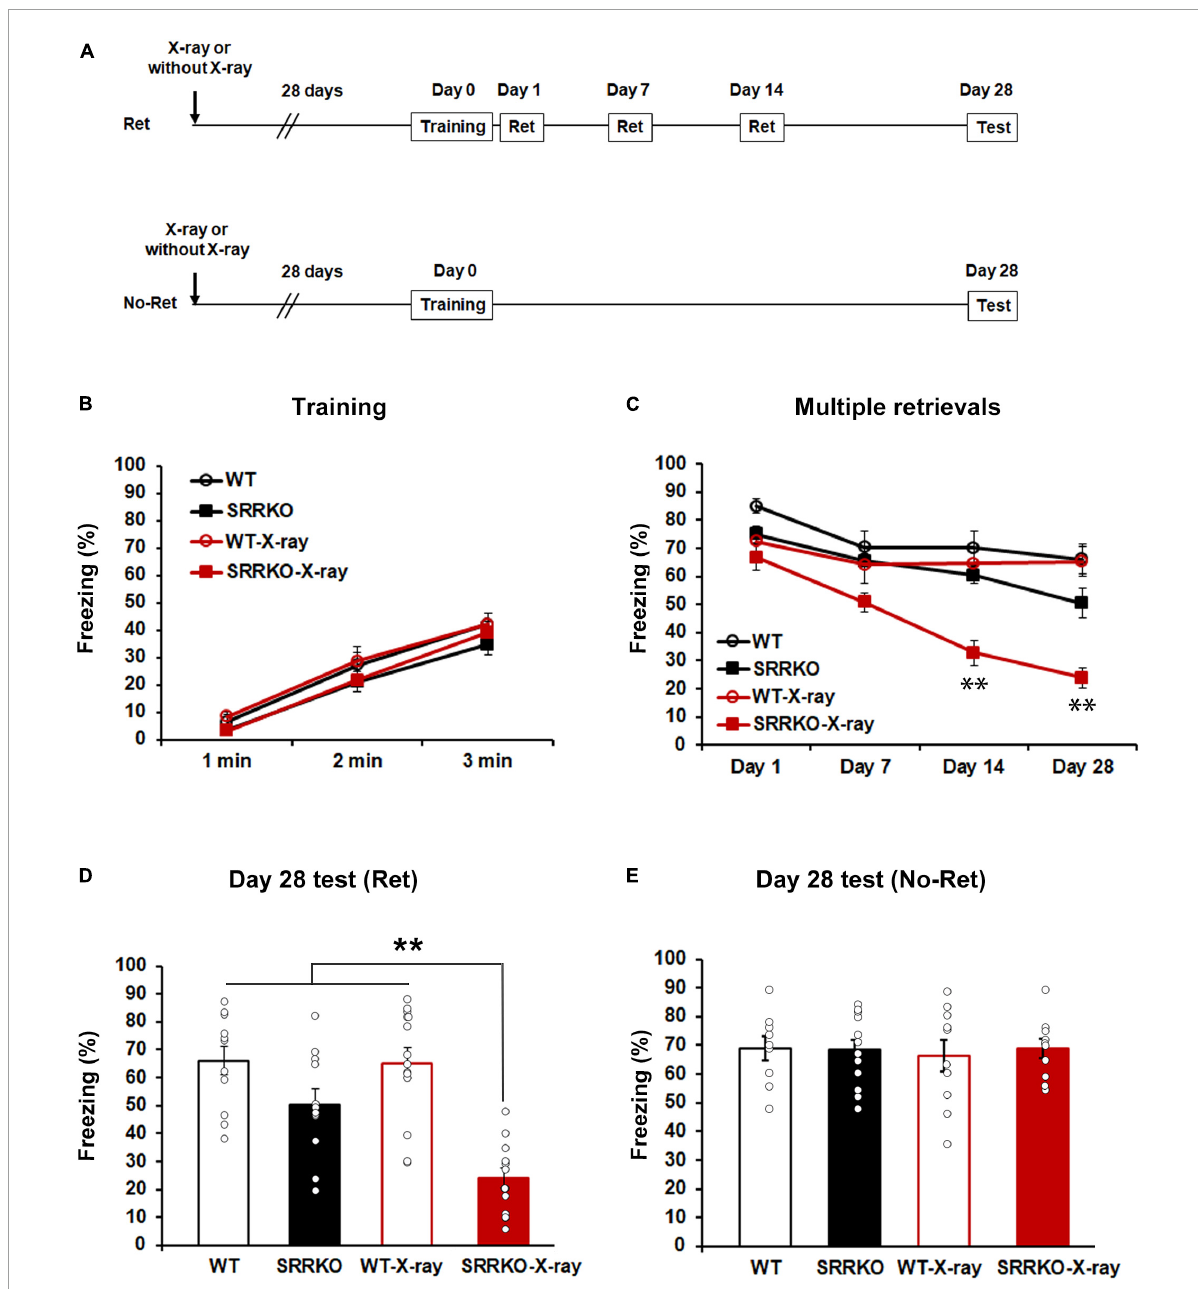
FIGURE1 Hippocampal neurogenesis dampening attenuates remote fear memory following multiple retrievals in SRRKO mice. (A) Experimental schedule for X-ray irradiation, contextual fear conditioning, and multiple retrievals. Two different protocols, one with multiple retrievals (Ret), and another without memory retrieval (No–Ret), were used. (B) No significant difference was observed in freezing between WT ( n = 11), SRRKO ( n = 12), WT-X-ray ( n = 14), and SRRKO-X-ray ( n = 13) mice during fear conditioning. (C) During the course of four retrieval sessions, SRRKO-X-ray mice exhibited a significant reduction in freezing levels compared to other three groups in the tests on day 14 and 28. (D) During the remote test on day 28, SRRKO-X-ray mice exhibited significantly lower freezing levels compared to the other three groups. (E) Under the condition without intervention of multiple retrievals, no significant difference was observed in freezing level between four groups (WT, n = 9; SRRKO, n = 12; WT-X-ray, n = 10; SRRKO-X-ray, n = 10) during the remote memory test on day 28. Data are presented as the means ± SEM. ∗∗ p < 0.01.